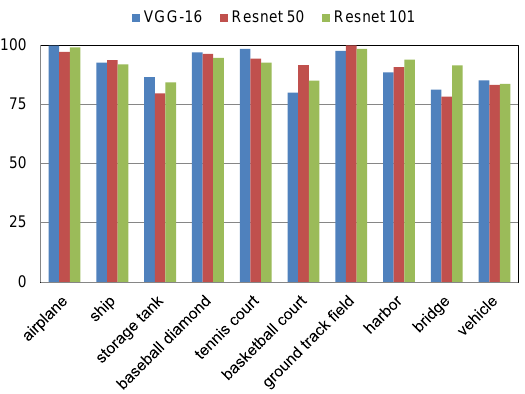
Figure 6. Detection results of the proposed model in terms of AP using different backbones: VGG-16, Resnet 50, and Resnet